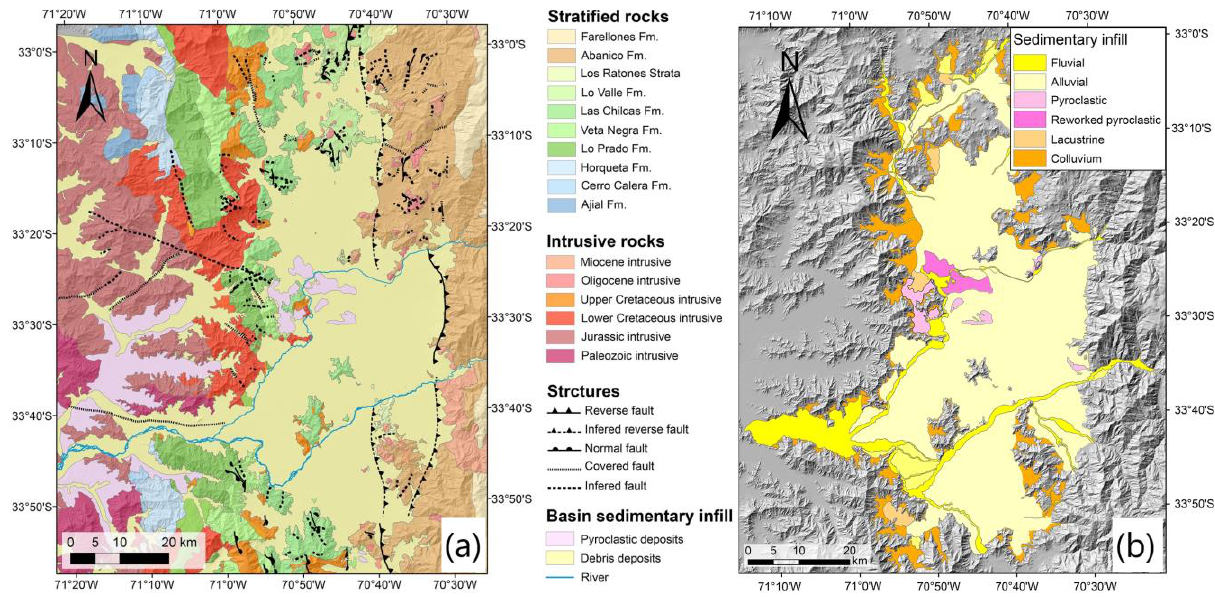
Figure 2. ( a ) Geological map and ( b ) Sediment map of Santiago Basin (From Yanez et al. [3]).